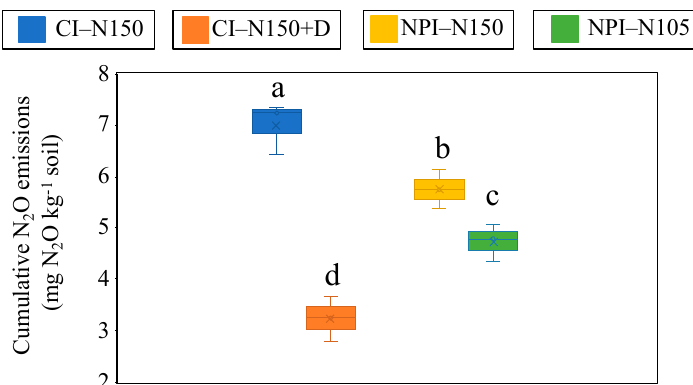
Figure 6. Cumulative N 2 O emissions under different irrigation and N treatments. CI is conventional irrigation, and NPI is negative pressure irrigation. N150: 150 kg N ha − 1 , N105: 105 kg N ha − 1 , D is DCD addition. All of the data are the means of three replicates ± SE, and different letters indicate significant differences between the treatments ( p < 0.05) by Duncan’s tests.